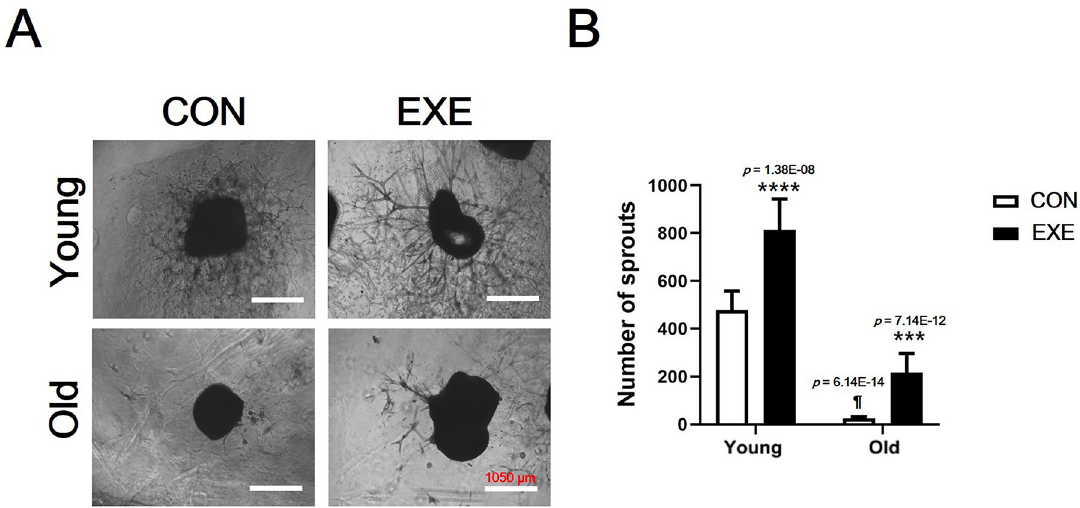
Fig 7. Inhibitory effect of LSE on the reduction of angiogenic capacity confirmed by ex vivo aortic ring assay. (A) 10 × magnification microscopic images of aortic ring assay. (B) Comparison of the number of sprouts extending after culture of isolated mouse aorta. All data are presented as the mean ± SD vs. control group of same age, ��� p < 0.001 and ���� p < 0.0001; vs. control group of different age, ¶ p <